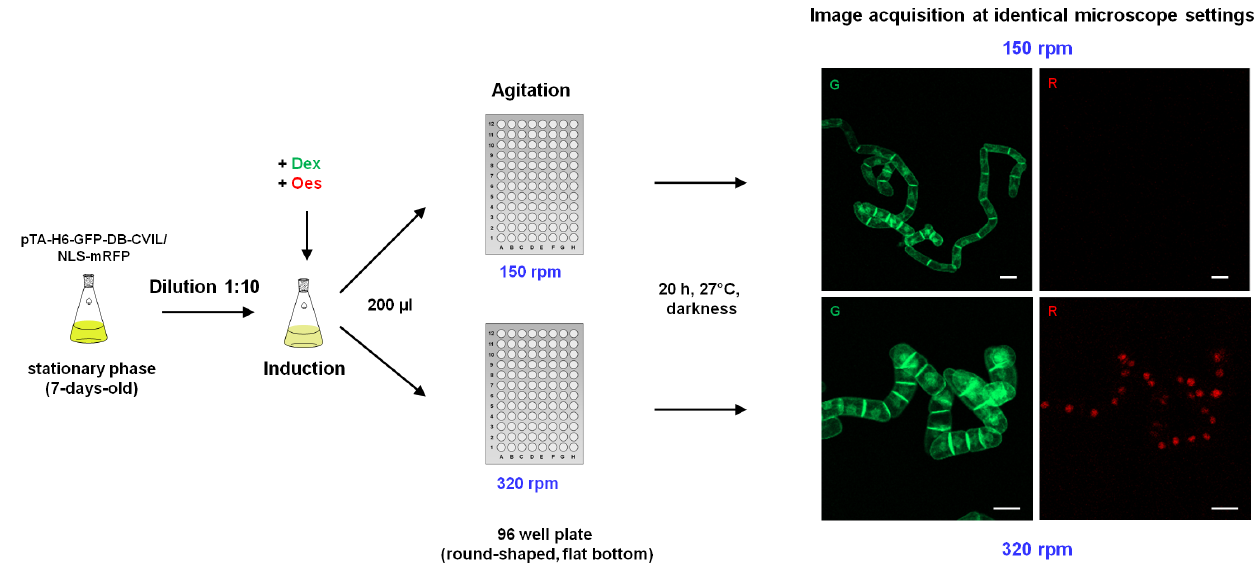
Figure 15. Influence of different shaking conditions. Shown is the expression of both fluorescent reporter proteins in transgenic tobacco BY-2 cells incubated over-night in the wells of a 96-well microtiter plate. A 7-day-old culture was diluted tenfold into a fresh culture medium before the inducers Dex (10 µM) and Est (5 µM) were added. Afterwards 200 µl of the cell suspension were added to the wells of a 96-well glass-bottom microtiter plate and shaken under different conditions (150 rpm and 320 rpm, respectively) before being examined by fluorescence microscopy as described in previous Figure legends. White bars = 10